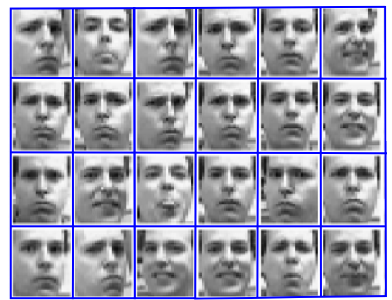
Figure 4: Samples from the face